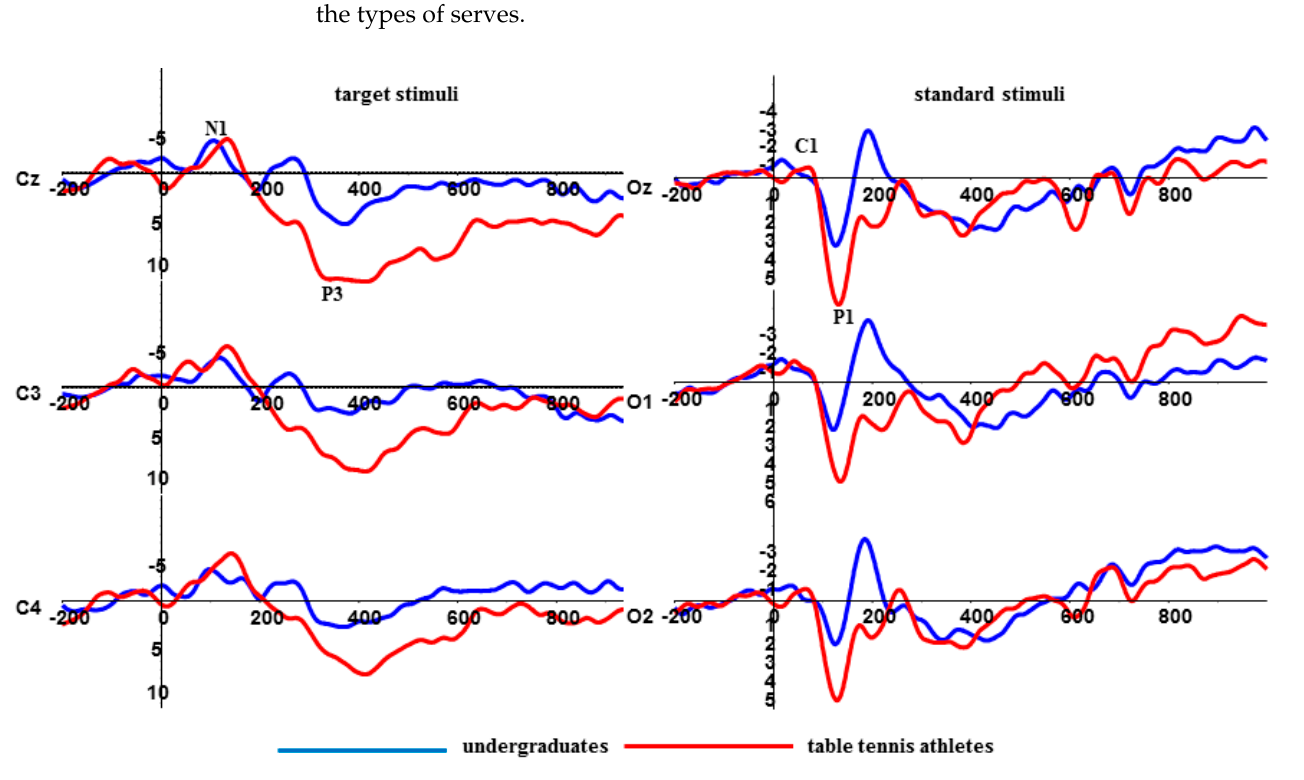
Figure 3. Grand average waveforms for correct responses of the two groups of participants. They were instructed to press a button whenever an infrequent target stimulus appeared in a series of frequent standard stimuli. The left waveforms of central sites (Cz, C3 and C4) were indexed by the responses to target stimuli, while the right of occipital sites (Oz, O1 and O2) were by standard stim-